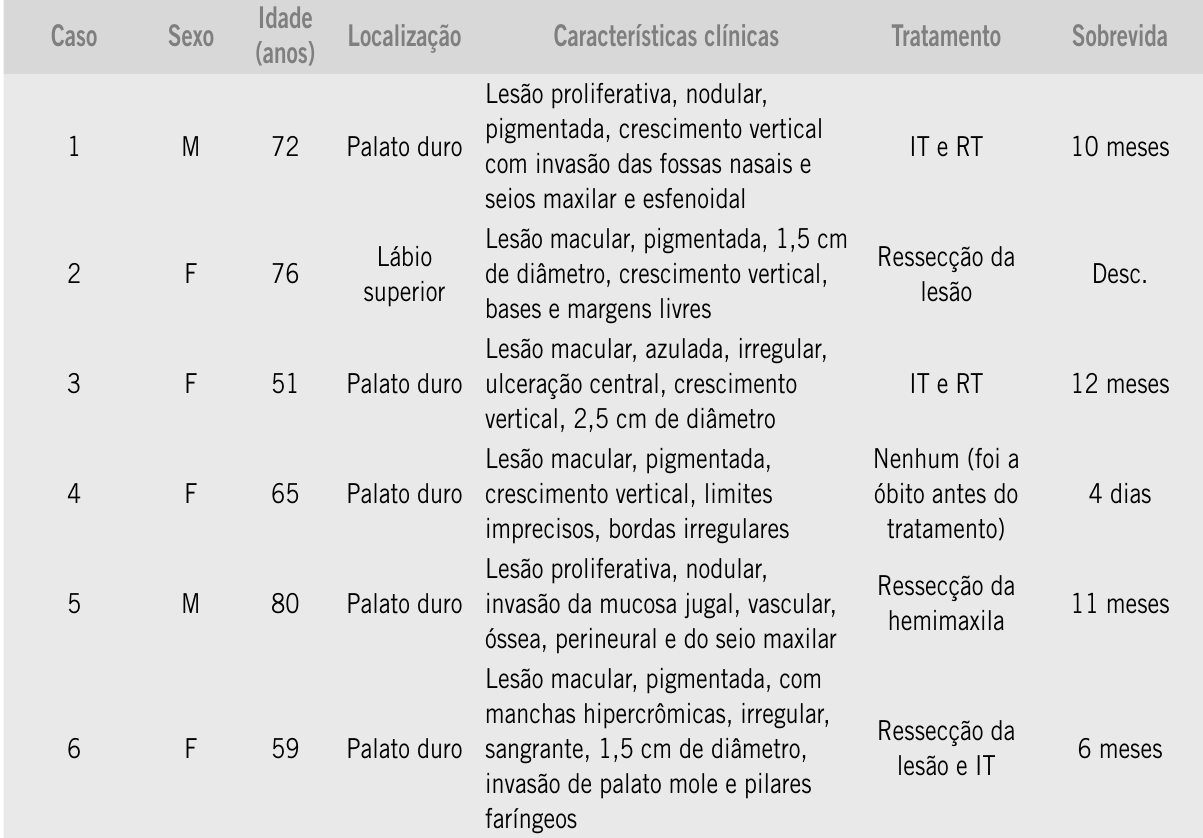
Sexo, idade, localização, características clínicas e tratamento dos casos de melanoma localizados na mucosa